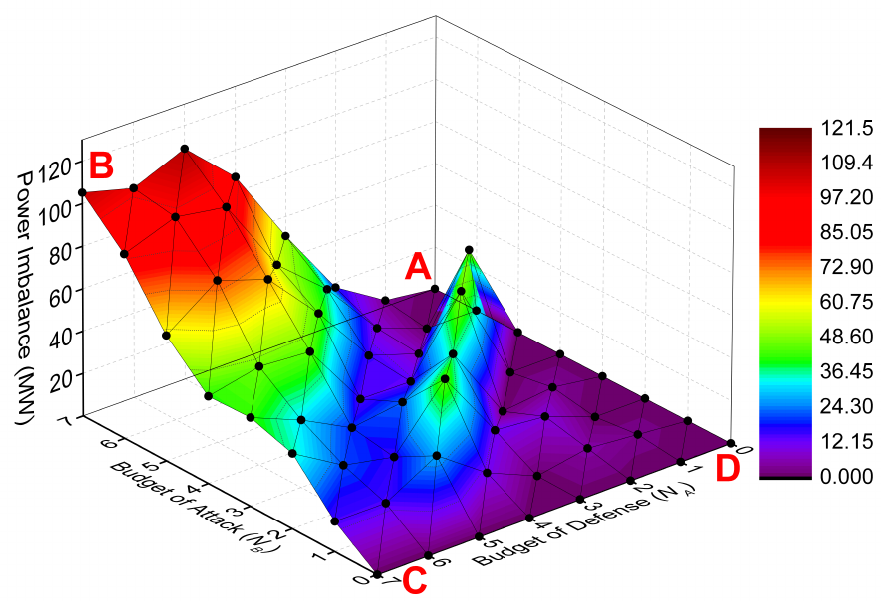
Figure 9. Difference of power imbalance with various fortification strategies under different defense and attack